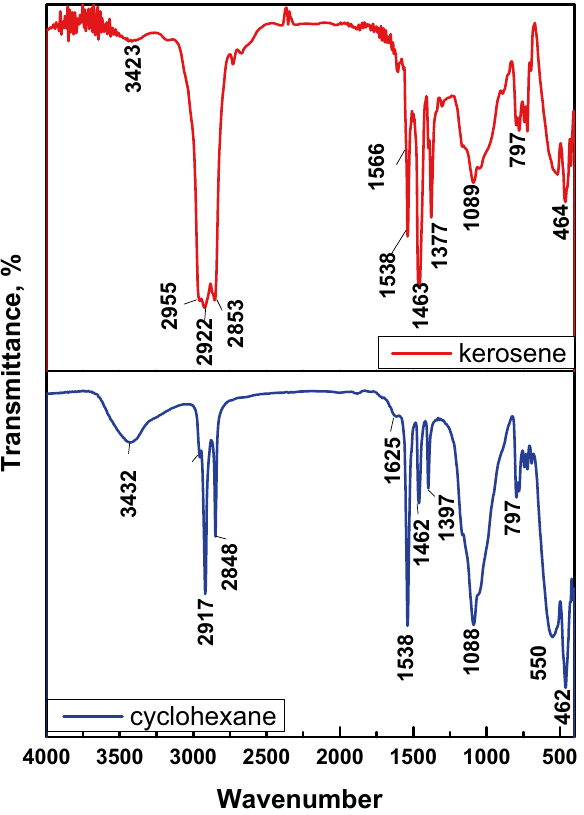
Figure 9. FTIR spectra of ZS@BIF composite loaded by kerosene and cyclohexane.